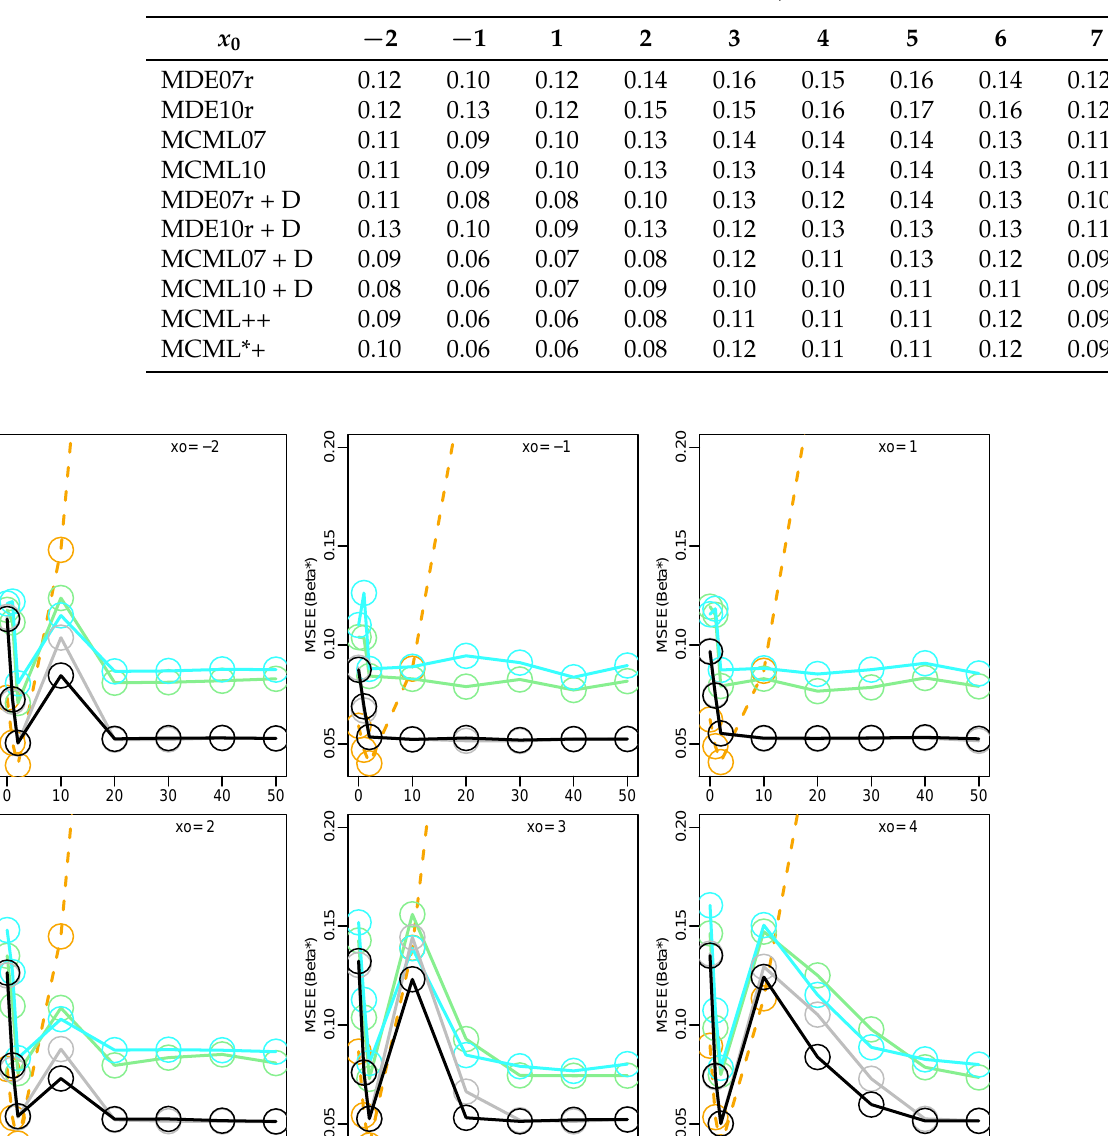
Table 4. Monte Carlo maximum MSEE (over y out ∈ { 0,1,2,10,20,30,40,50 } ) of the starting and DCML estimators of the Poisson regression under 10% point contamination in (( 1, x out ) T , y out ) , where x out = ( 0, x o ,0, . . . ,0 ) ( p = 10, γ = 0.5, α = 1, x ∗ ∼ N ( 0 , I p − 1 ) ).